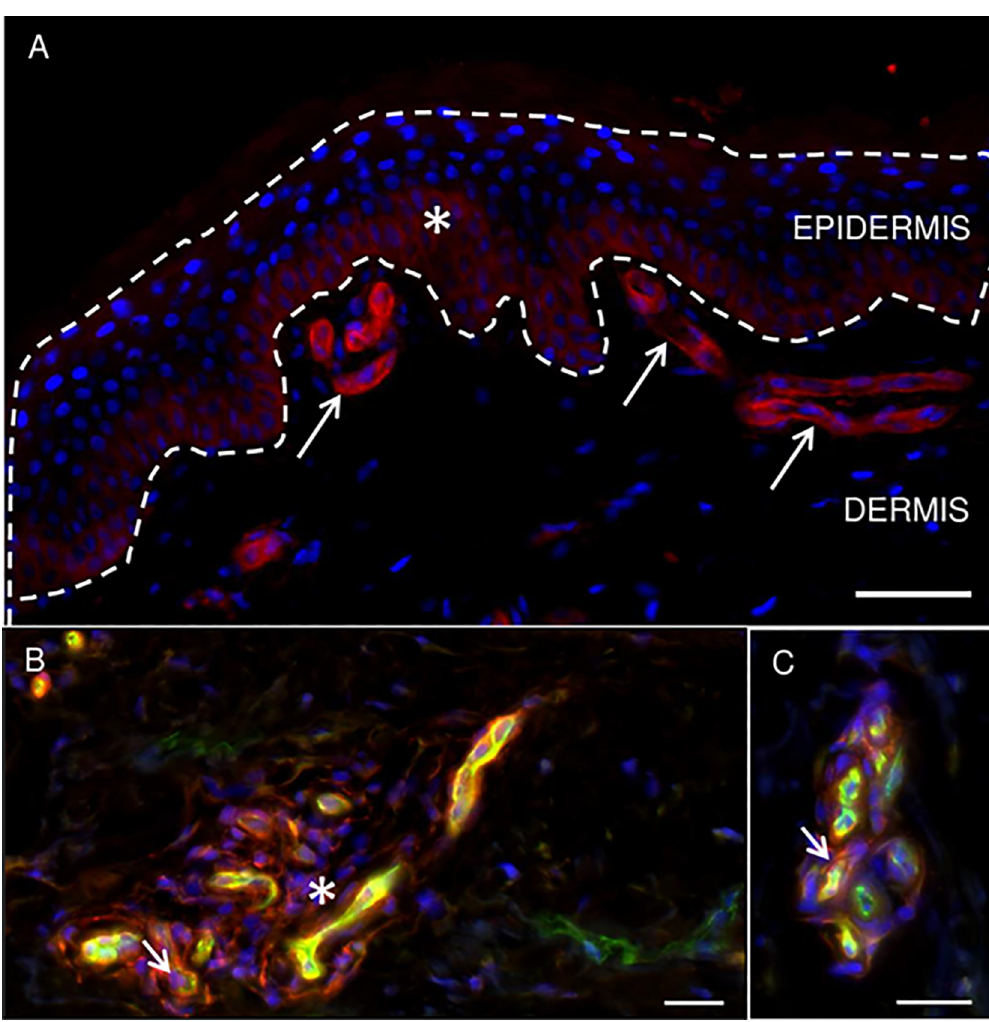
Fig 4. NRP-1 receptor expression related to epidermis and dermal vasculature in skin of healthy volunteers. (A) NRP-1 receptor expression in human skin biopsy. NRP-1 was present in dermal vasculature (arrows) and basal keratinocytes of epidermis (asterix). (B and C) NRP-1 receptor (red) and CD31 (green) expression patterns in dermis of human skin biopsy. NRP-1 was present in dermal vasculature (yellow, co- localization of NRP-1 and CD31), adjacent to vessels (arrow; CD31, green) and in cells with a fibroblastic phenotype (asterix). Hoechst counterstain (blue). Scalebar: 20 μ